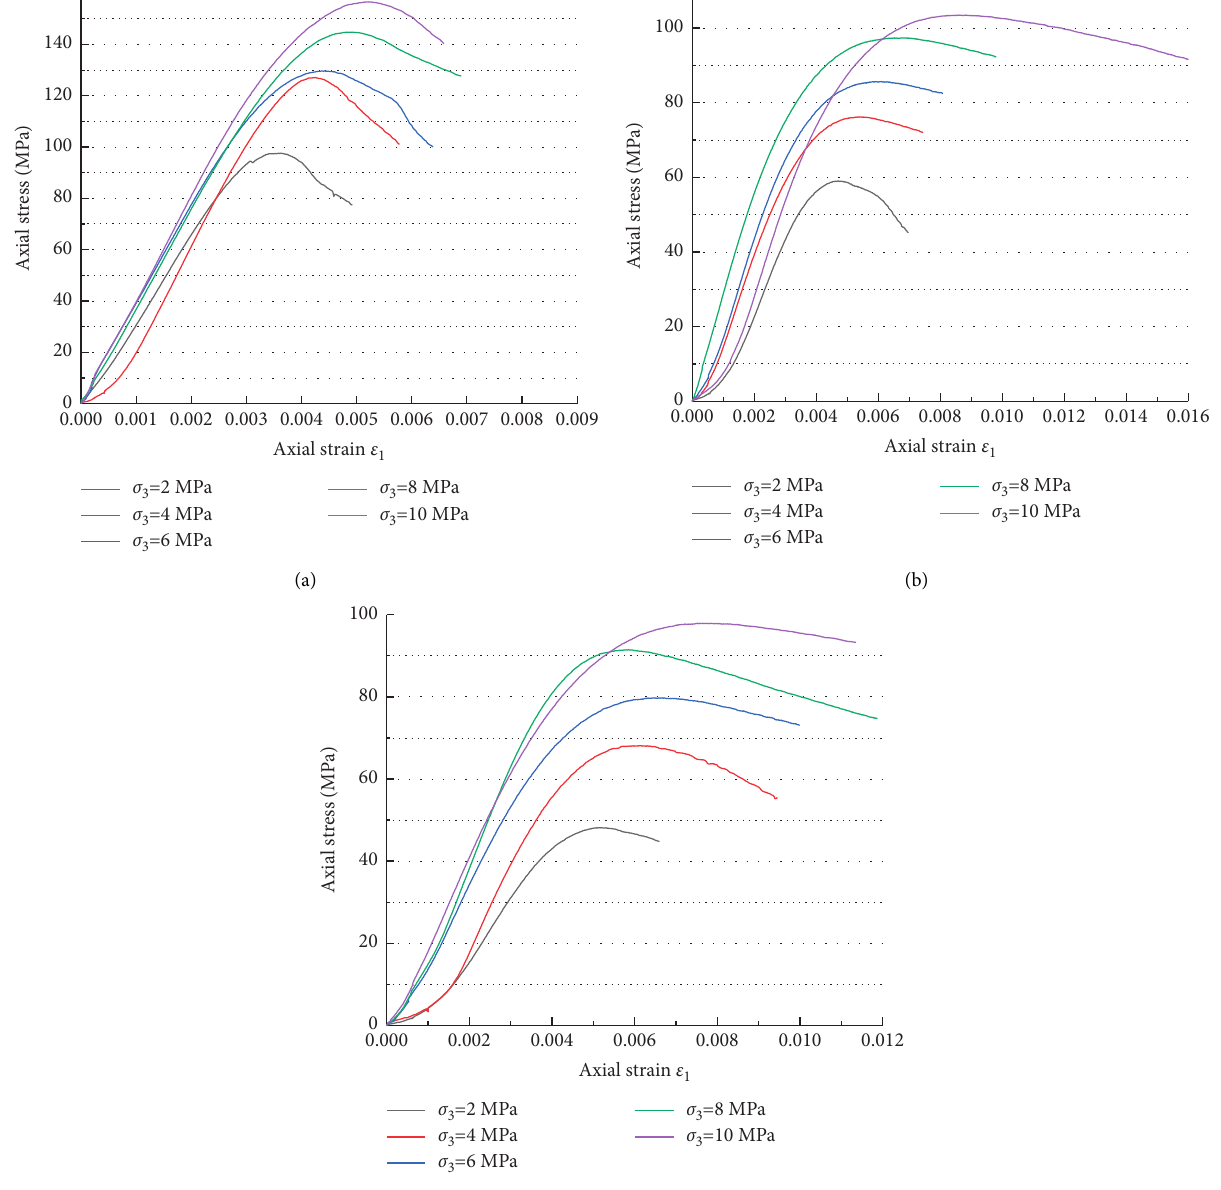
Figure 3: Stress-strain curves of samples under triaxial compression: (a) group A samples under triaxial compression, (b) group B samples under triaxial compression, and (c) group C samples under triaxial